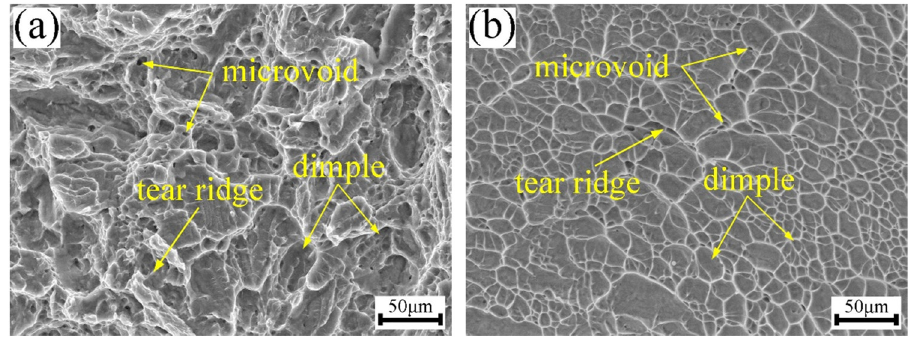
Figure 13: SEM images of joint tensile fracture: ( a ) EBW joint and ( b ) P -